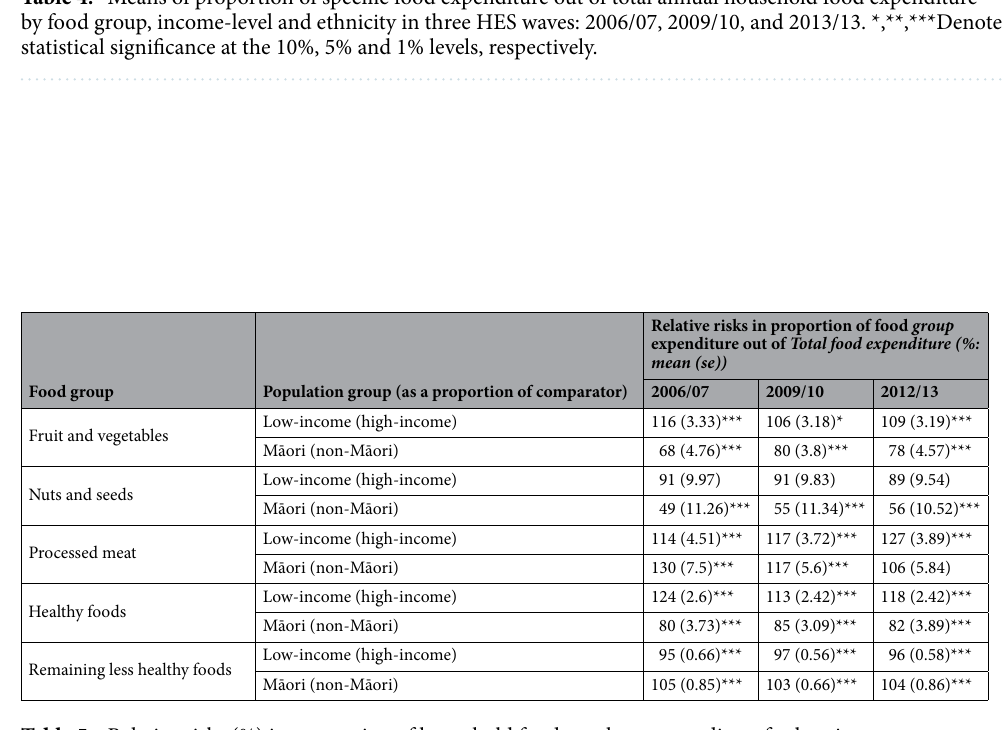
Table 5. Relative risks (%) in proportion of household food purchase expenditure for low-income as proportion of high-income and Māori as proportion of non-Māori households, HES 2006/07, 2009/10, and 2012/13. a Values in this table were derived using linear regressions with the survey year and income-level/ ethnicity as independent variables. *, **, ***Denote statistical significance at the 10%, 5% and 1% levels,